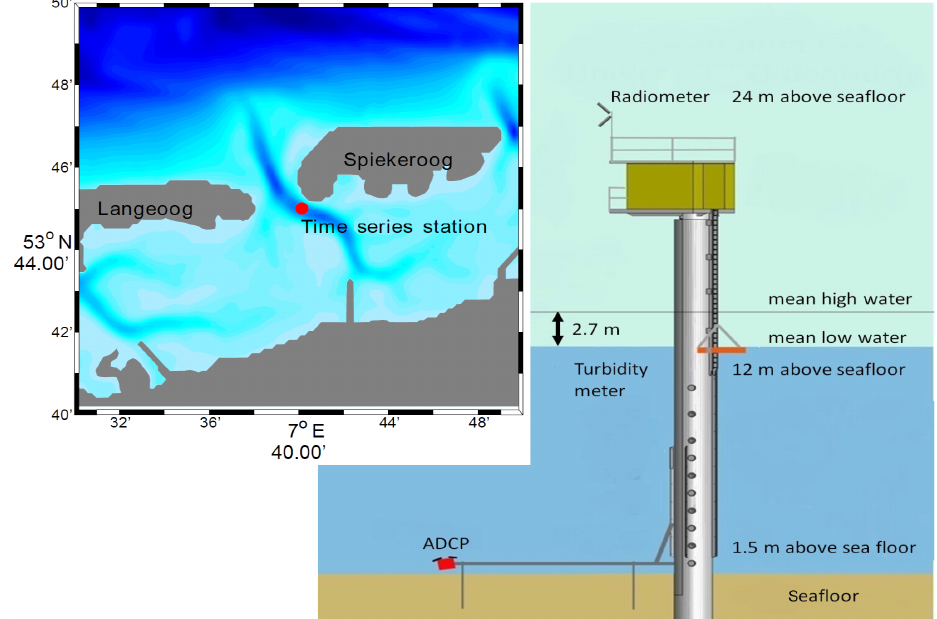
Figure 1. Schematic of the Time Series Station Spiekeroog showing the position of the radiometers (24m), the turbidity metre (12m), and the ADCP (1.5m above the seafloor). The typical water depth is 13.5m with tidal range of about 2.7m between mean high and low water. The insert shows the location of the Time Series Station where the colours indicate the water depth at high